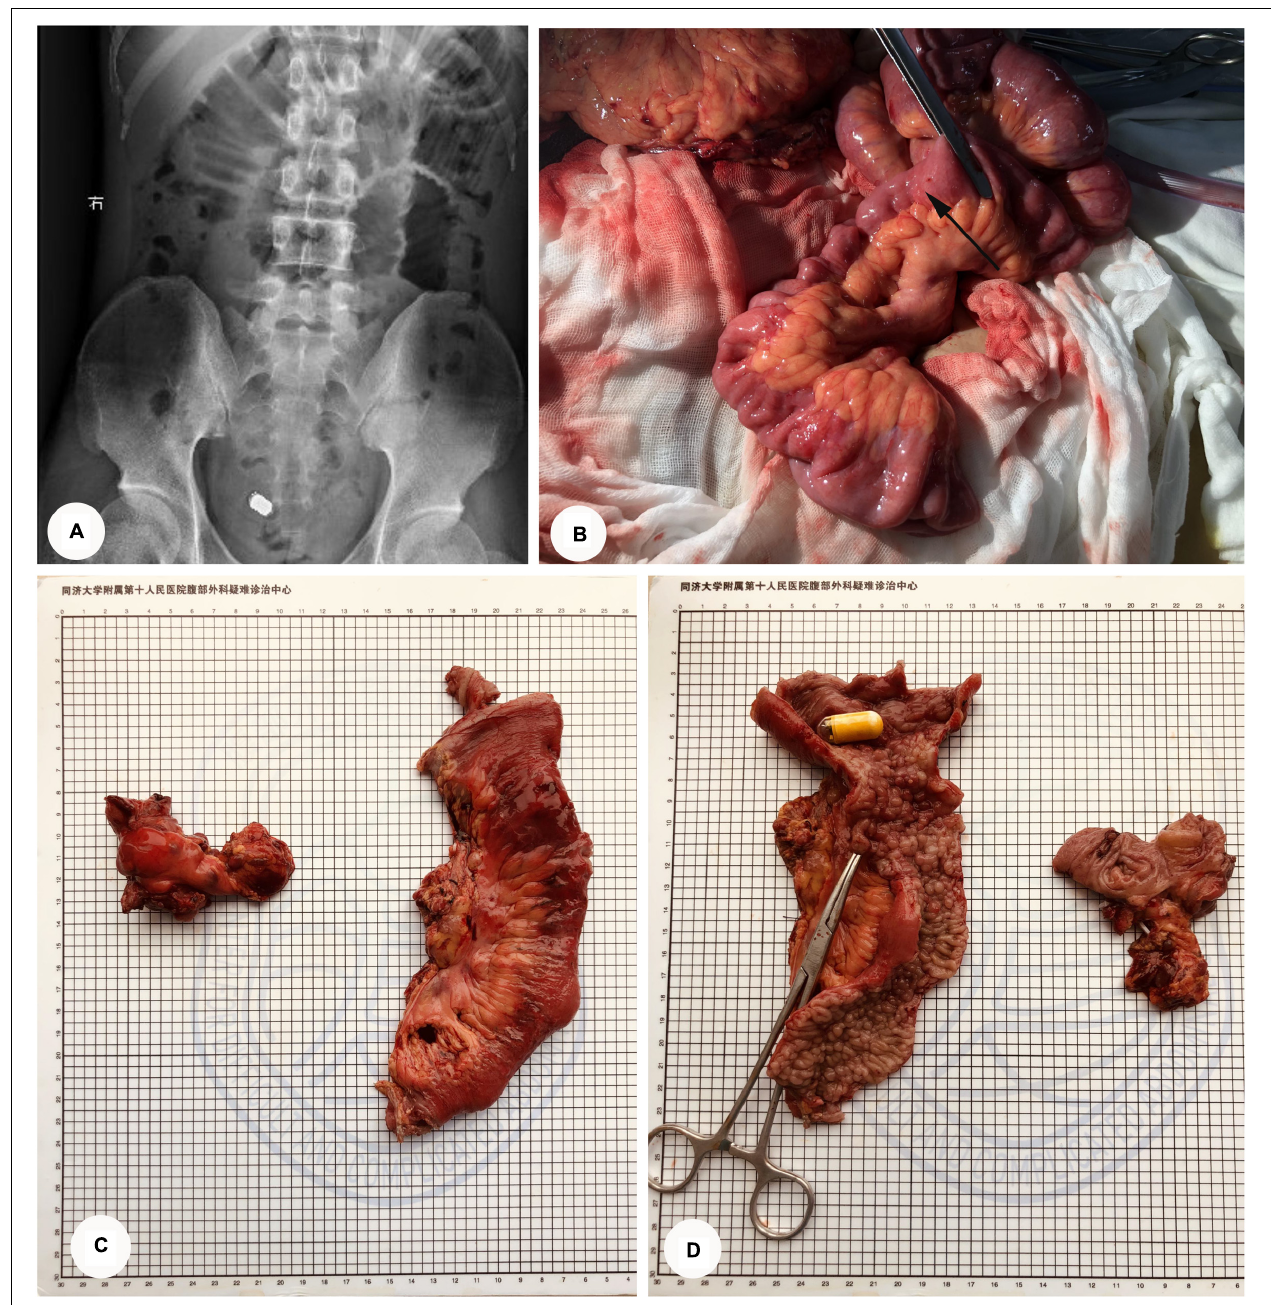
FIGURE 1 | CD complicated by small intestinal obstruction with capsule endoscopic incarceration (Case 1). (A) Abdominal plain film: the jejunum in the upper left abdomen was dilated, and the intestinal cavity contained a gas-liquid plane. Metallic shadows could be seen in the overlapping area of the pelvic cavity. (B) Intraoperative exploration: the capsule endoscope is incarcerated in the narrowed proximal ileum (Arrow point). (C,D) The specimen of surgery: the yellow cylinder is capsule endoscope; vascular clamp showing internal